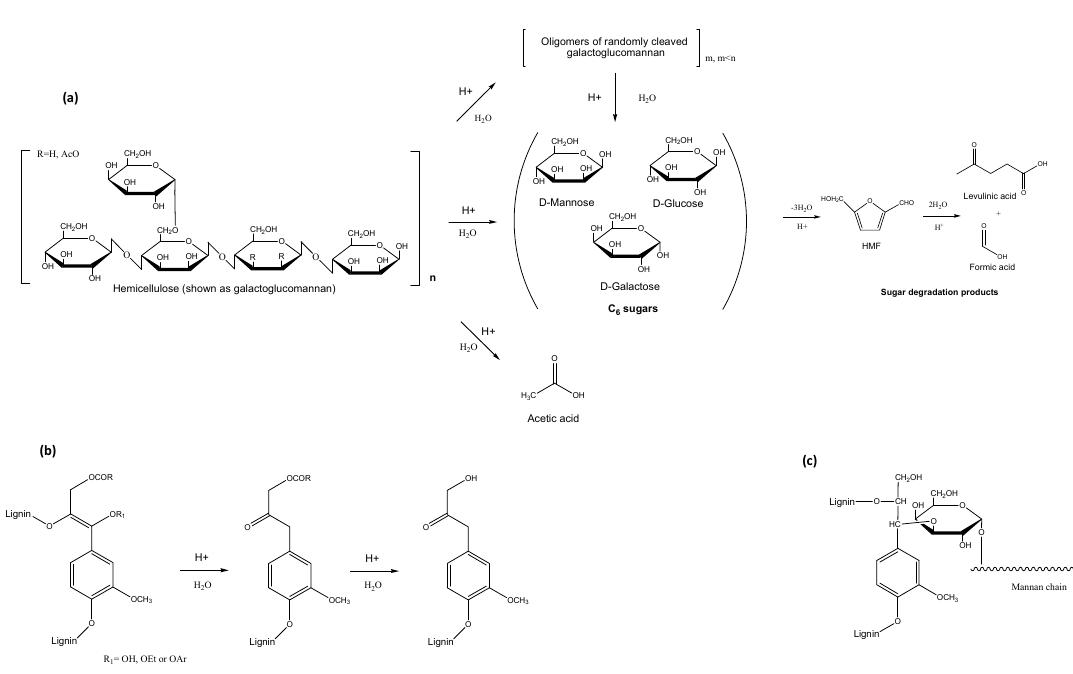
Figure 2. ( a ) Reaction scheme of acid catalyzed hydrolysis and degradation of a typical softwood hemicellulose. The hemicellulose is presented as a galactoglucomannan heteropolysaccharide with a glucose-mannose backbone connected with a β -1-4 glucosidic bond, and a galactose side chain connected to the backbone with a mannose molecule via a-1-6 glucosidic bond. The glucose:galactose:mannose ratio is 1:1:3 and the hemicellulose can be acetylated in positions 2 and 3 of the mannose molecule. Under acidic conditions hemicellulose is randomly cleaved to give oligomers of various size as well as monomeric sugars. These can be furthermore degraded to furans and organic acids; ( b ) Acid catalyzed cleavage of the aryl ether bonds in lignin [47]; ( c ) ether bond between a G moiety of a softwood lignin and a galactose side chain of a softwood